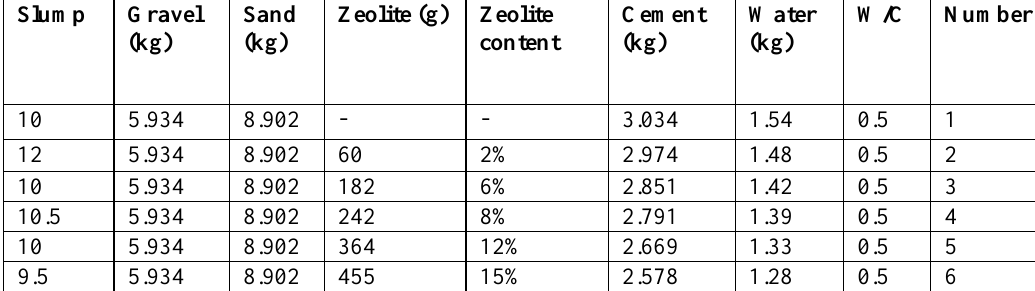
Component values of 360 kg / m 3 concrete mixes